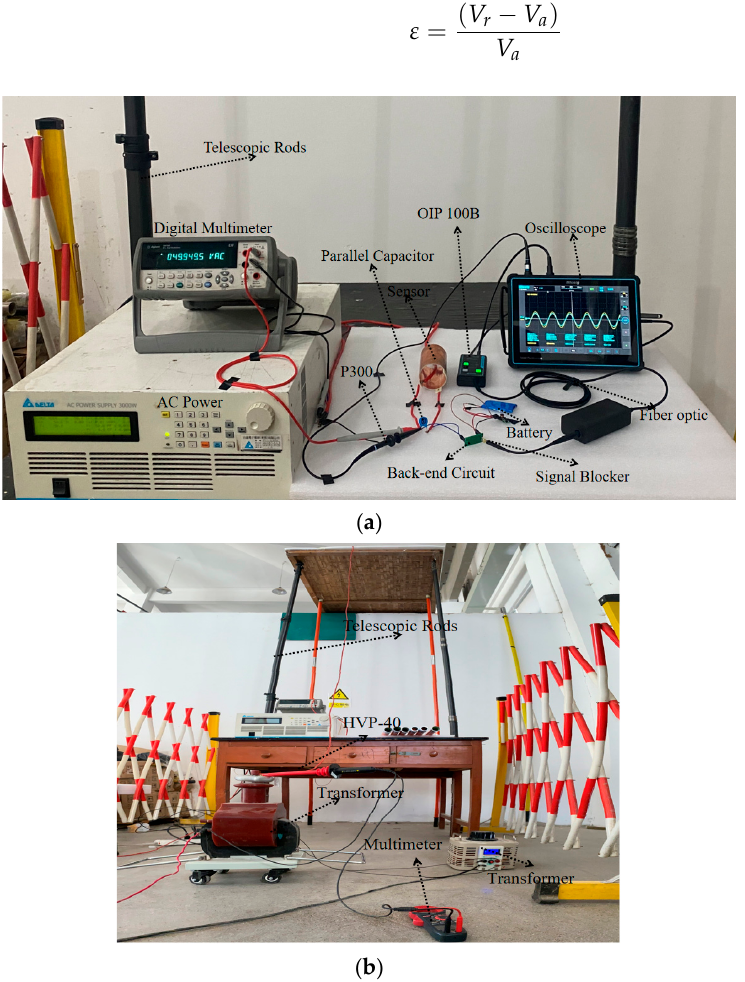
Figure 13. Schematic diagram of the experimental platform. ( a ) Low Voltage Test Platform; ( b ) High Voltage Test Platform.